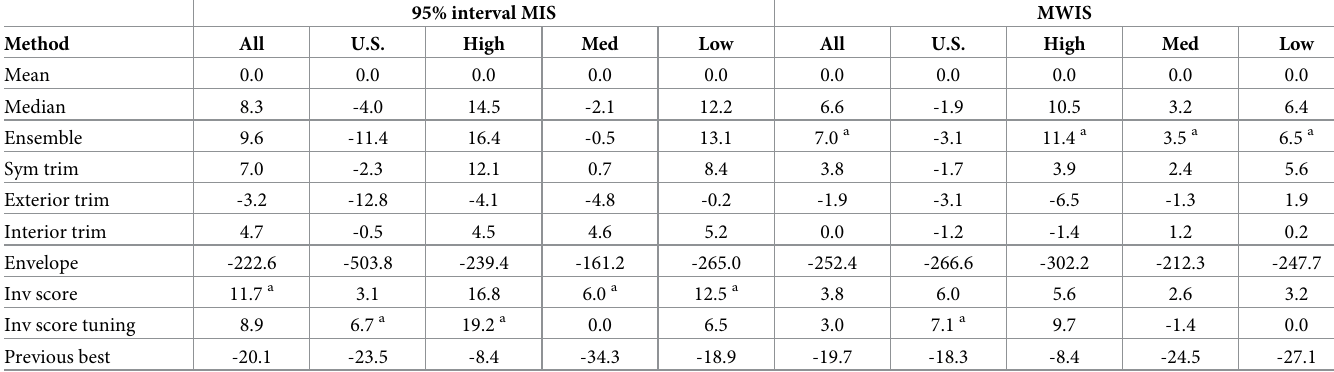
Table 2. For incident mortality, skill scores for 95% interval MIS and MWIS.